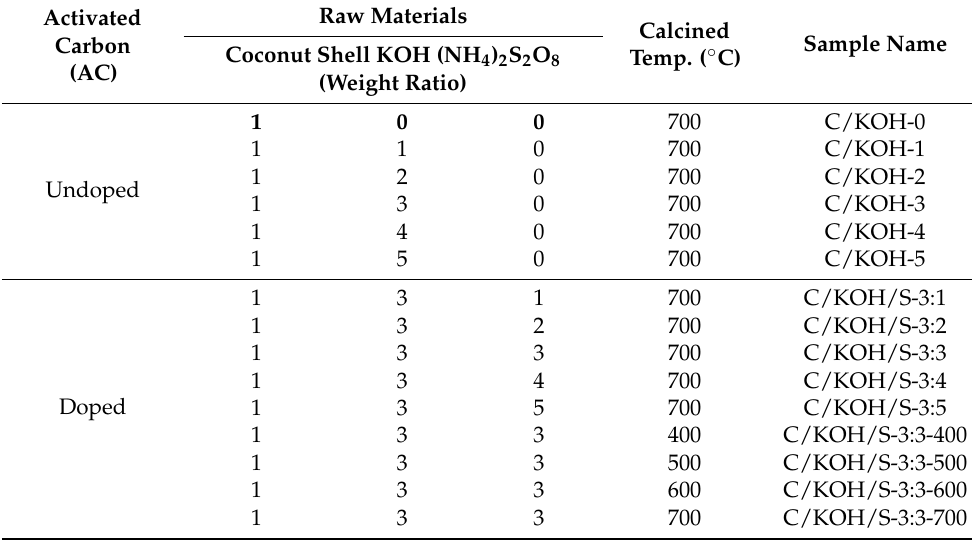
Table 1. The preparatory conditions of the as-prepared activated carbon obtained using coconut shell as raw